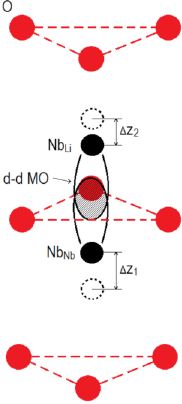
Figure 5. Formation of a bipolaron pair Nb Li -Nb Nb in the structure of a LN crystal.